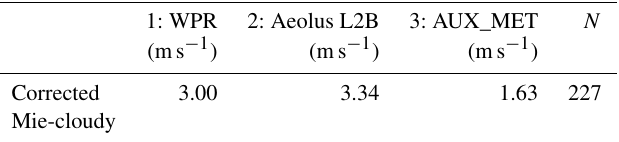
Table A2. Error standard deviation of three different systems.